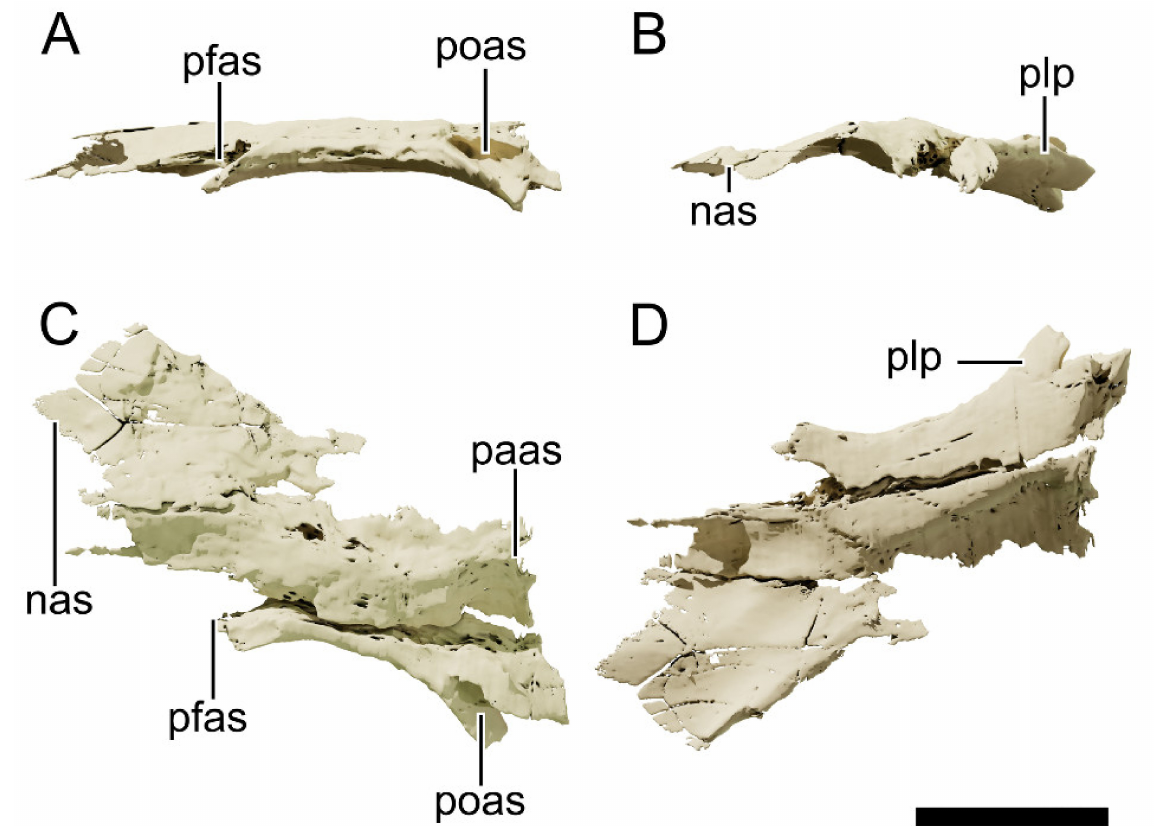
Figure 21. Digital reconstruction of the frontals of NHMD 164758. ( A ) Lateral view. ( B ) Anterior view. ( C ) Dorsal view. ( D ) Posterior view. The left and right frontals were digitally articulated. Abbreviations: nas, articular surface for the nasal; paas, articular surface for the parietal; pfas, articular surface for the prefrontal; poas, articular surface for the postorbital; plp, posterolateral process; stf, supratemporal fossa. Scale bar = 20